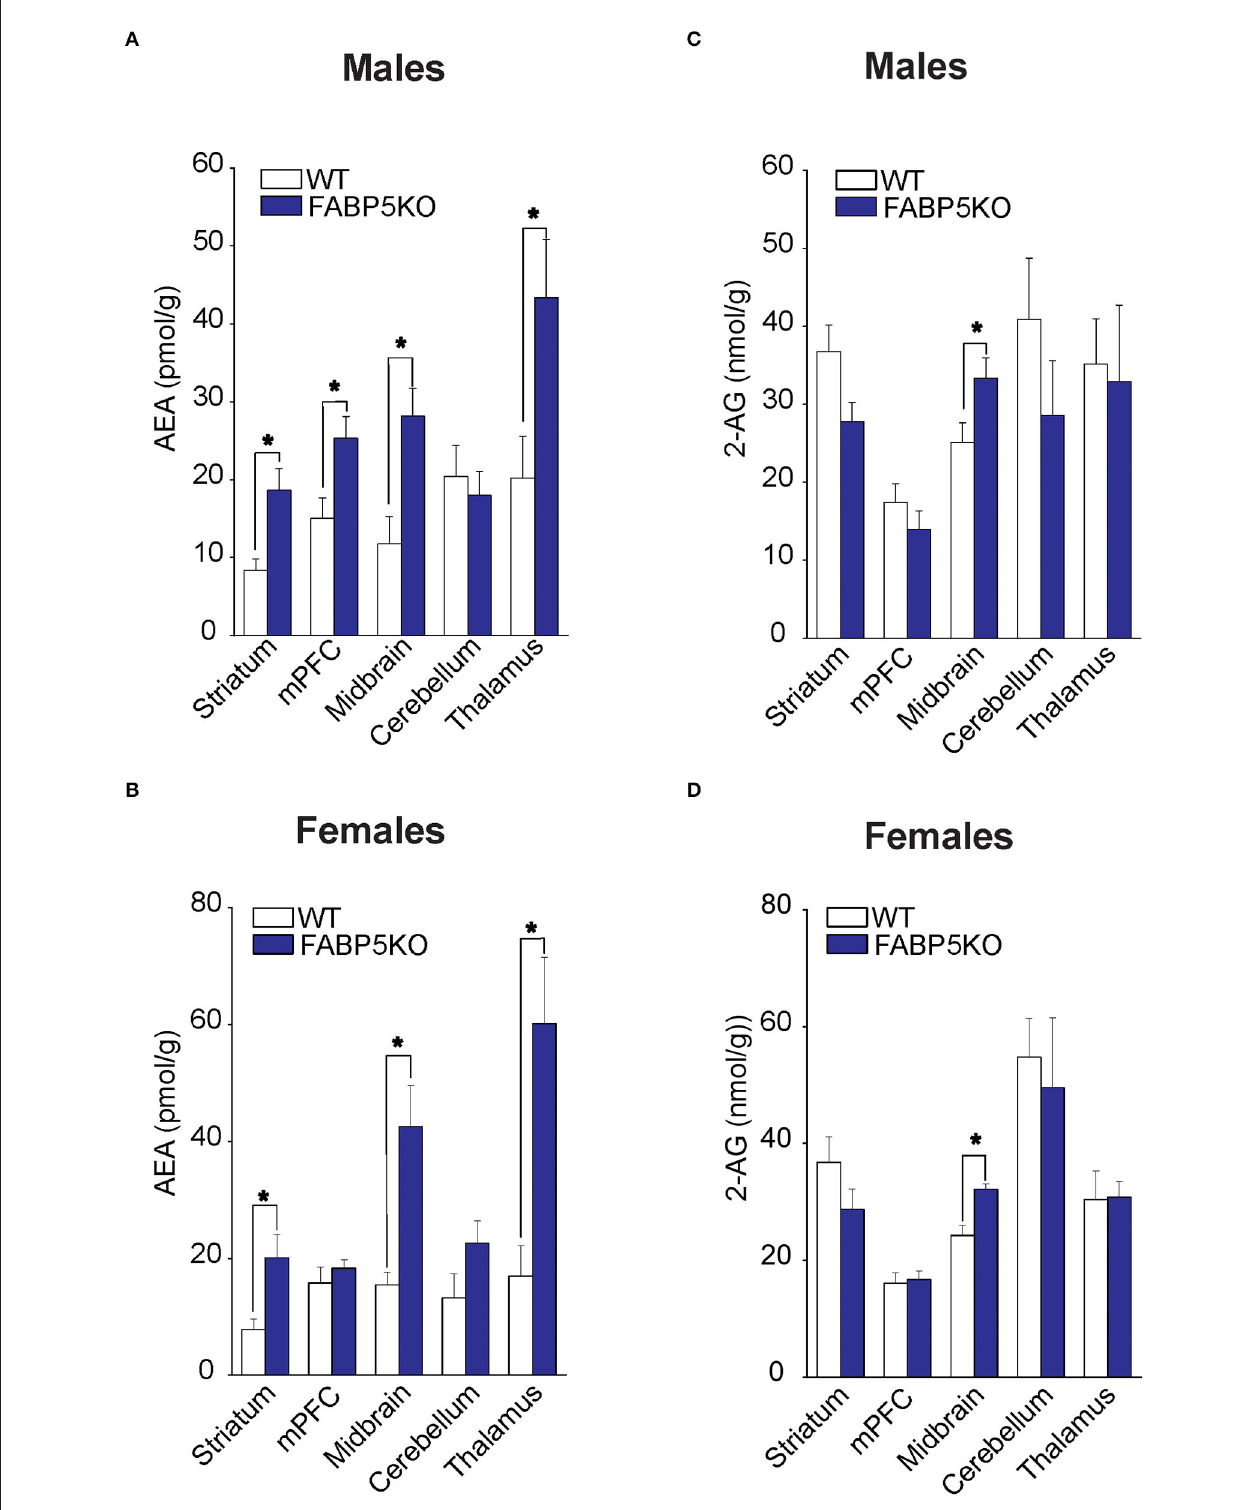
FIGURE 2 | 2-AG and AEA levels in brain regions of WT vs. FABP5 KO mice. Levels of AEA (A,B) and 2-AG (C,D) in the striatum, mPFC, midbrain, cerebellum, and thalamus of male and female WT and FABP5 KO mice ( n = 5). *, p < 0.05; KO vs. WT.